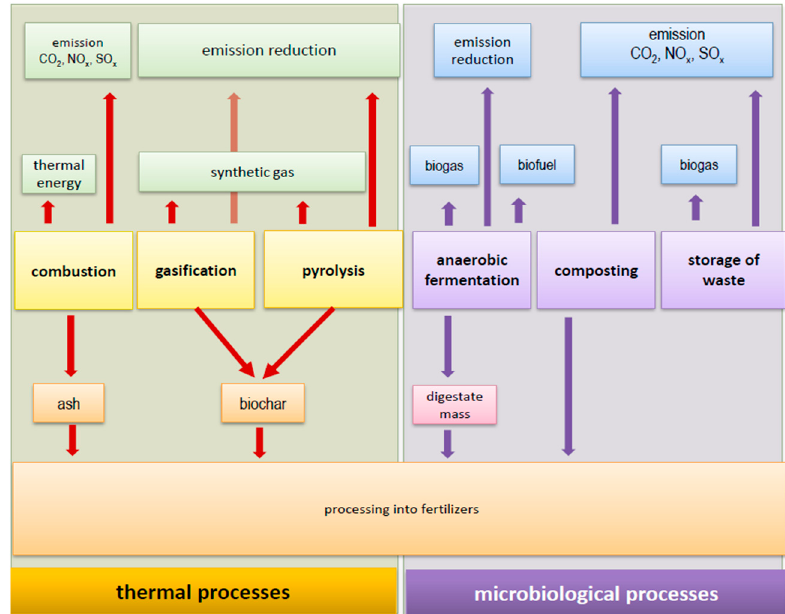
Figure 2. Directions and processes of organic waste utilisation.